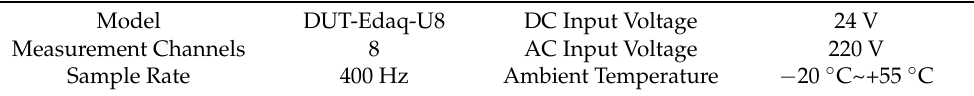
Table 2. Parameters of the DAQ device.